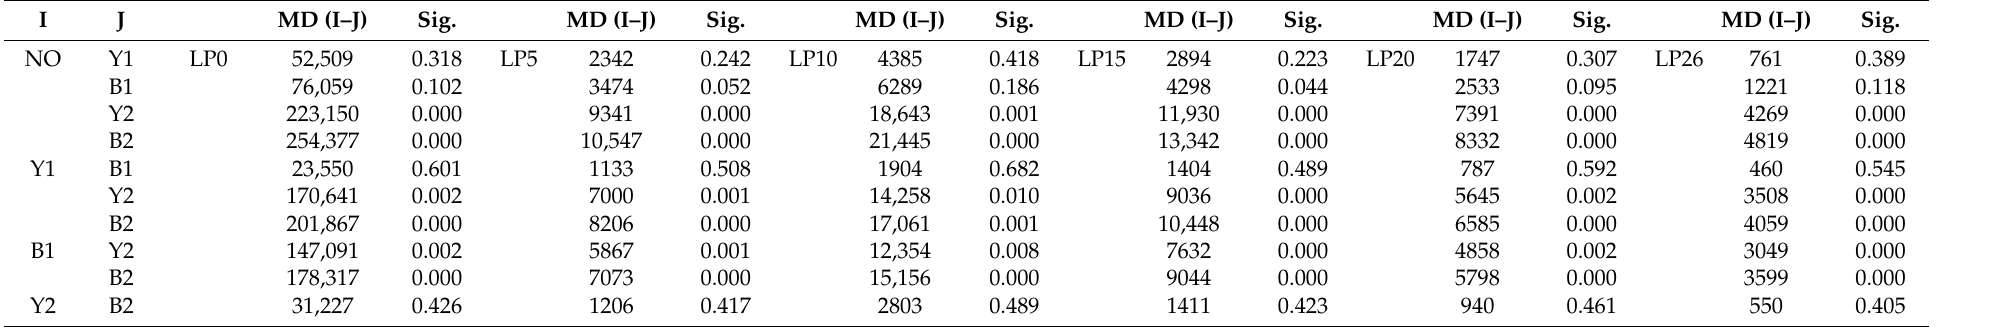
Table A5. Labor population post hoc tests—multiple comparisons using